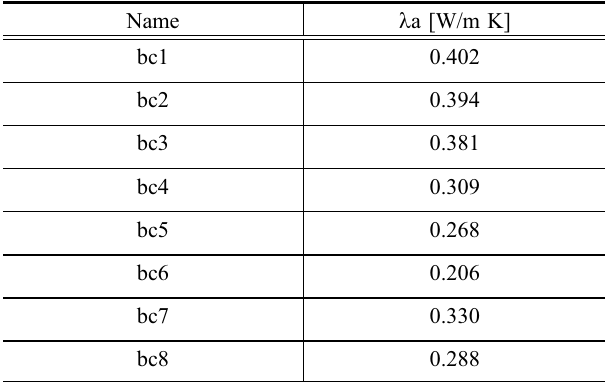
Table 8 Scaling cumulated mass. Table 9 Values of the thermal conductivity of the concretes without sand in W/m